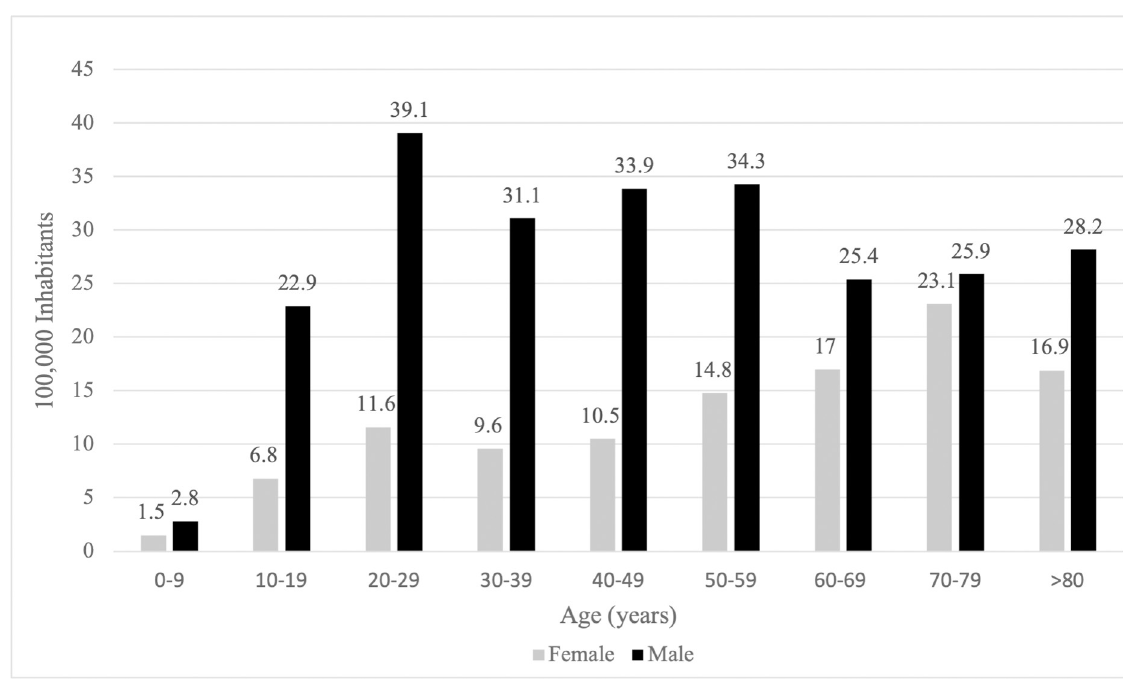
Fig 1. Road traffic accident among the AIS Thorax � 2 group per 100,000 inhabitants in the Rhoˆne area population. Subgroups according to the age. AIS Thorax � 2 group: trauma patients presenting with at least one thoracic injury AIS � 2.AIS: abbreviated injury scale.